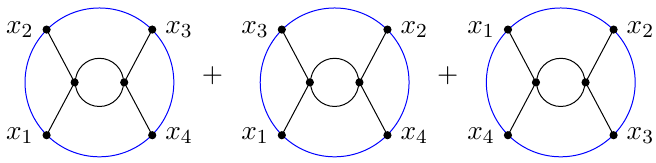
Figure 3 . One-loop Witten